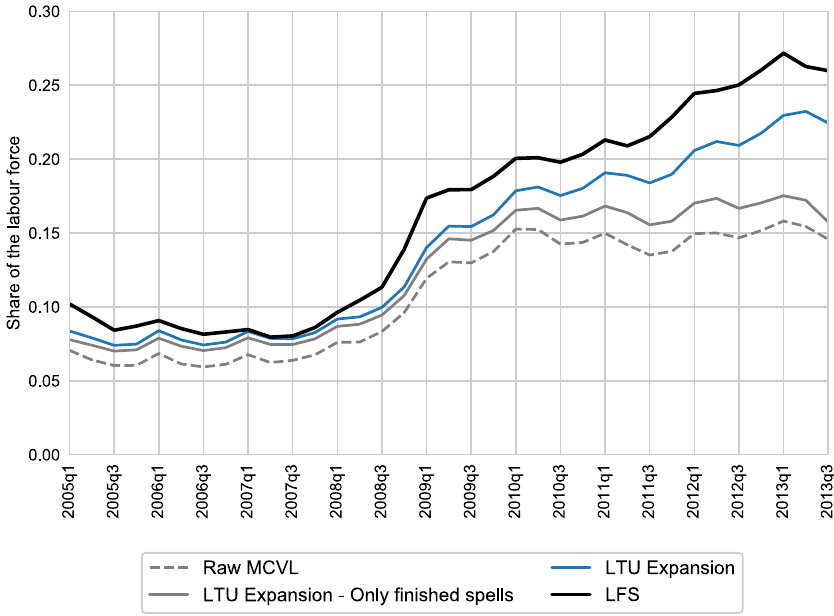
Fig. 4 Unemployment rates—LFS and expanded social security. Source : MCVL and the LFS. The LTU expansion—only finished spells series is calculated by applying the LTU expansion but excluding right- censored spells as the end of